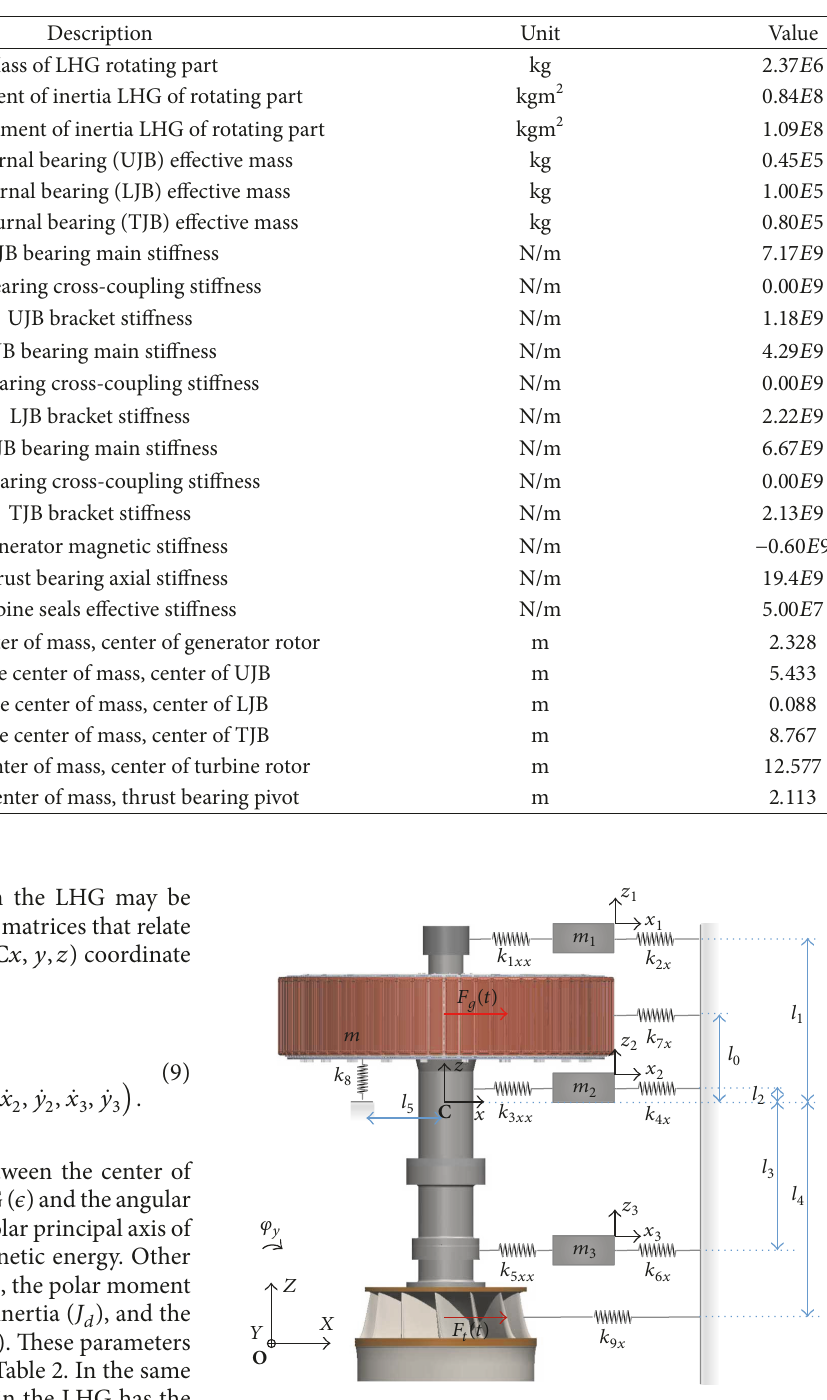
Table 2: Parameters of the Rigid Body Model.